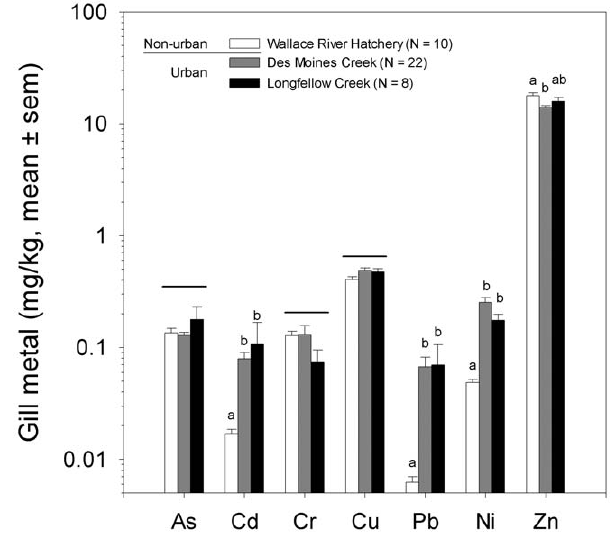
Figure 4. The gill tissues of prematurely dying coho contain elevated levels of cadmium, lead, and nickel. The concentrations of metals in the gills of affected coho from two urban streams (Longfellow and Des Moines Creeks) are plotted relative to samples collected from a non-urban hatchery (Wallace River). Error bars are 1 standard error of the mean. Letters indicate significant differences in measured levels of metals between sampling locations (one-way ANOVA, Tukey’s HSD; p , 0.05) and horizontal bars indicate no significant differences (p . 0.05).